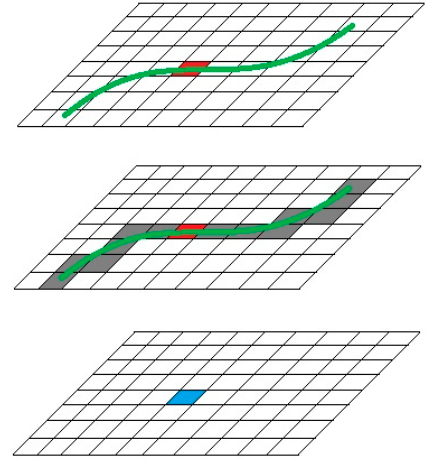
Figure 5. Line integral convolution overview. We extract a streamline (green) starting from a pixel (red) in both positive and negative directions, and compute a weighted average (blue) of pixels that streamline passed through (gray).